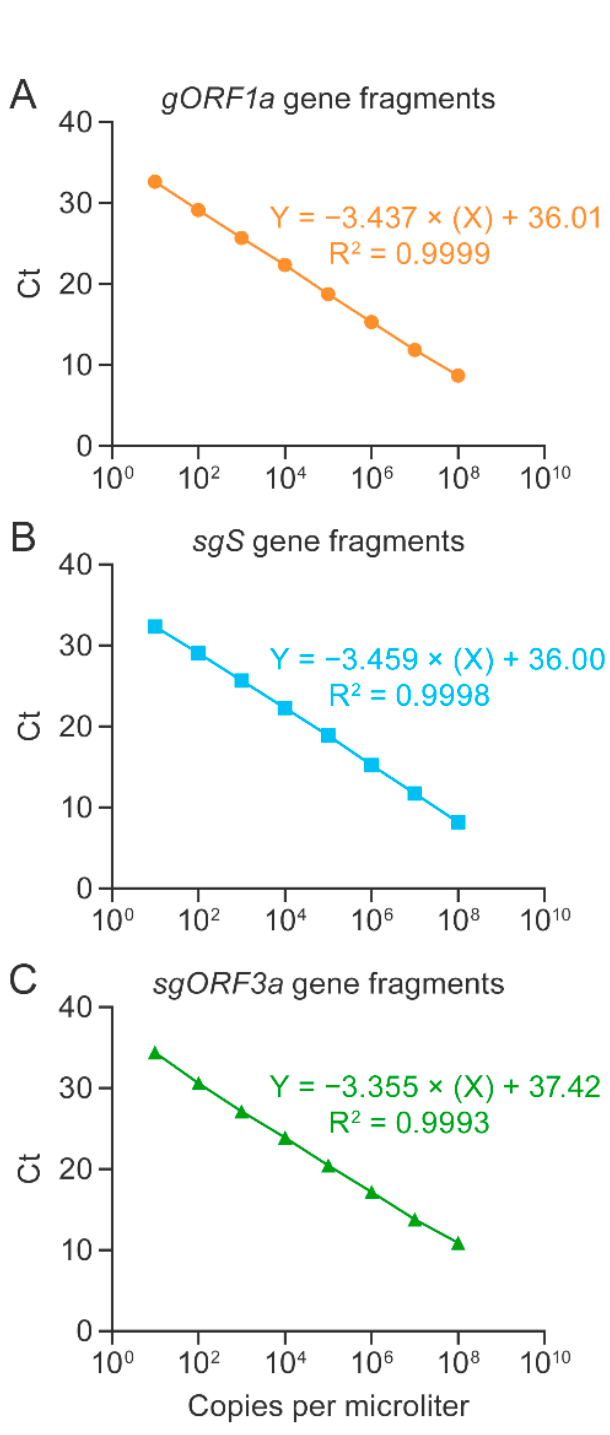
Figure 1. Singleplex RT-qPCR assays for the detection of SARS-CoV-2 RNA using synthetic gene fragments. Singleplex RT-qPCR assays were performed on serially diluted gene fragment standards to optimize detection of SARS-CoV-2 genomic ORF1a ( gORF1a ; ( A )), subgenomic S ( sgS ; ( B )) and subgenomic ORF3a ( sgORF3a ; ( C )). Experiments were performed thrice, with three replicates for each reaction. RT-qPCR = real-time reverse transcription PCR; SARS-CoV-2 = severe acute respiratory syndrome coronavirus 2.